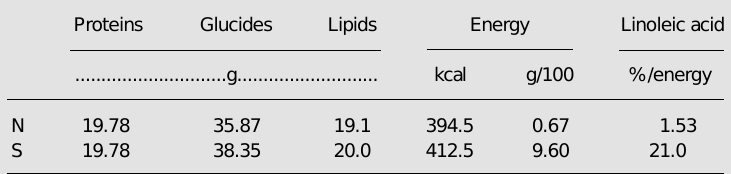
Table 1. Estimated centesimal chemistry of the